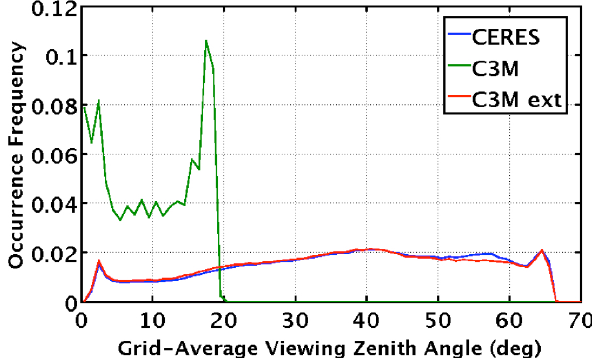
Figure 19. Distributions of grid-averaged viewing zenith angle for CERES data (blue), C3M data (green), and the C3M extended data (red), using data from April